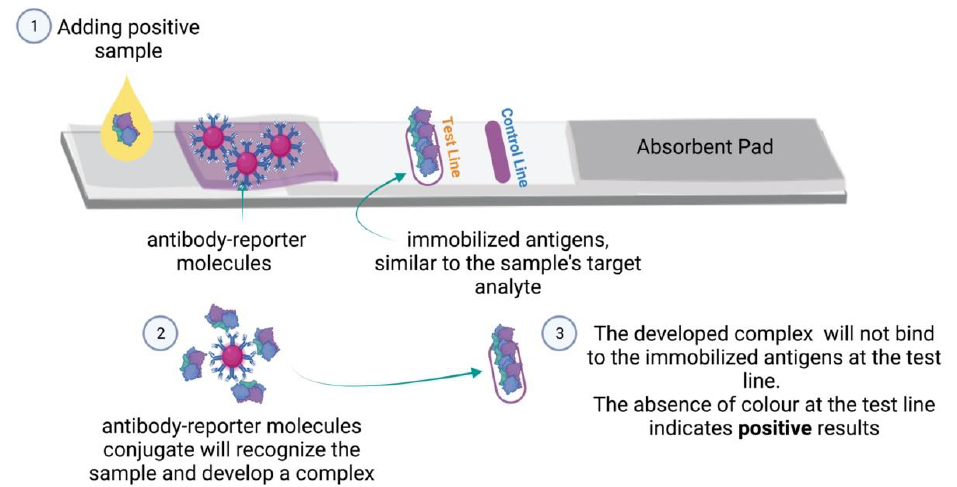
Figure 3. LFIA competitive format: Schematic of the competitive format LFIA components and principles.